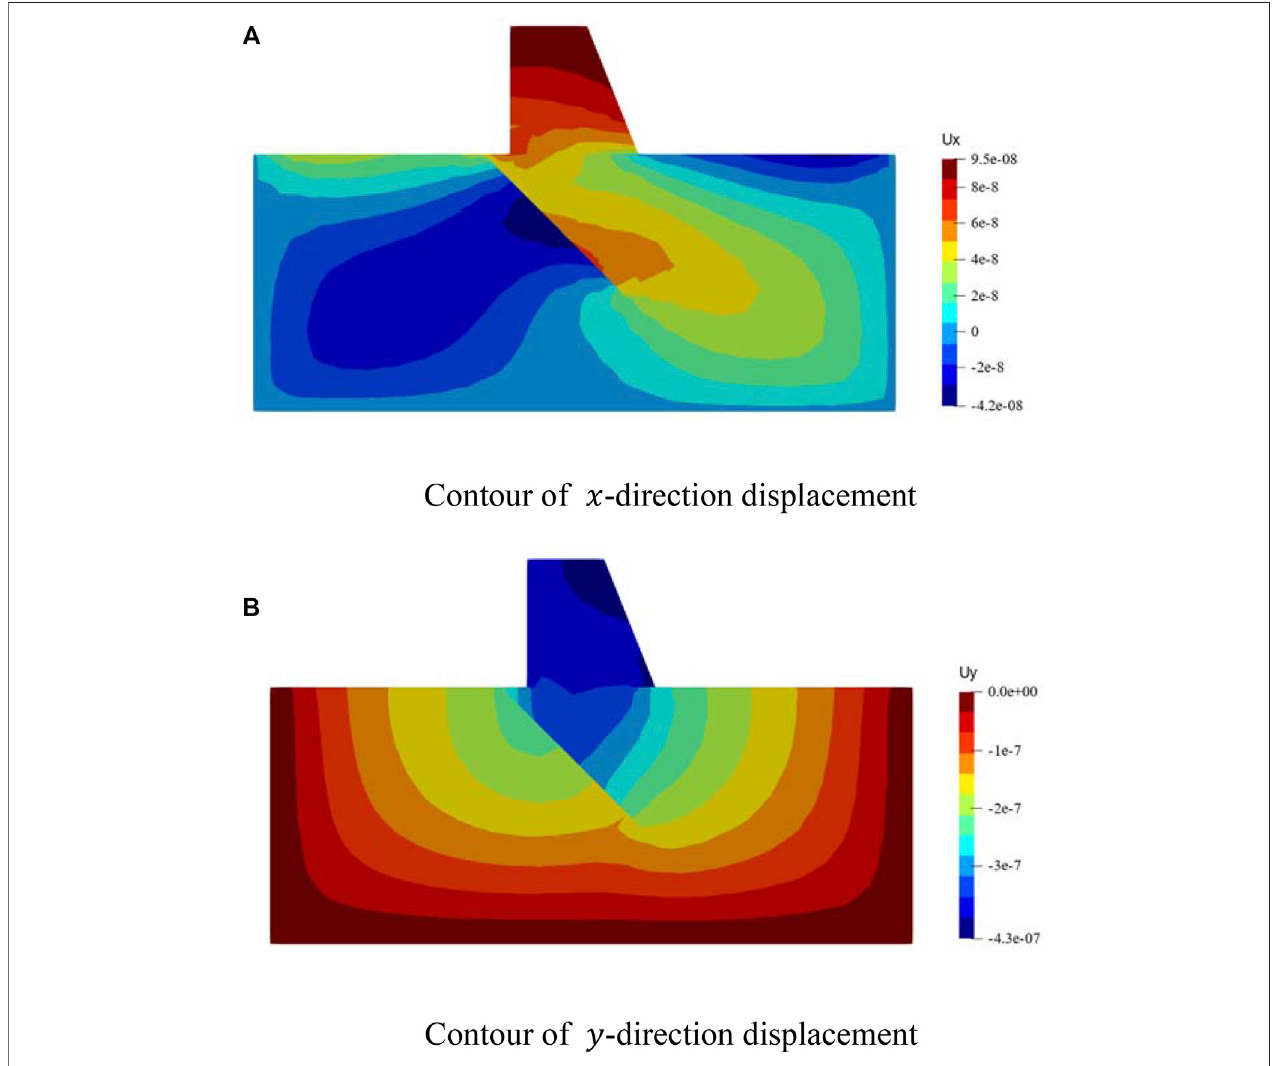
FIGURE 13 | The contours of displacement in x and y directions ( U x and U y are the displacement in displacement in x and y direction, respectively).